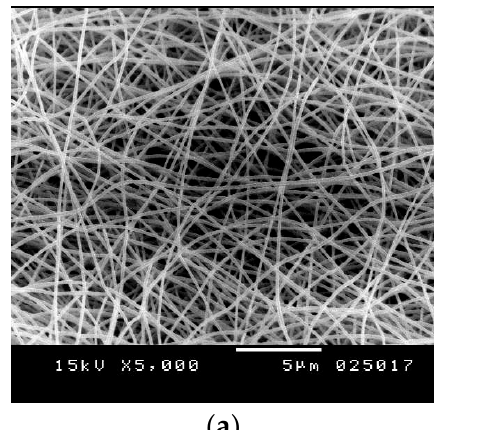
Figure 7. ( a ) Poly(vinyl alcohol) (PVA) 10% needle electrode at 15 cm, 1 mL/h. and 25 kV. ( b ) Mean diameter distribution of produced fibers by needle electrode.